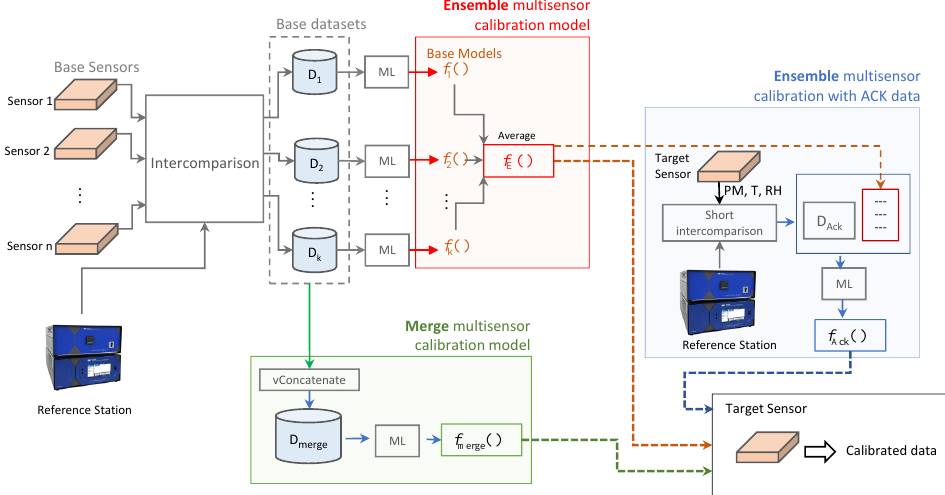
Figure 7. Proposed framework for multisensor calibration